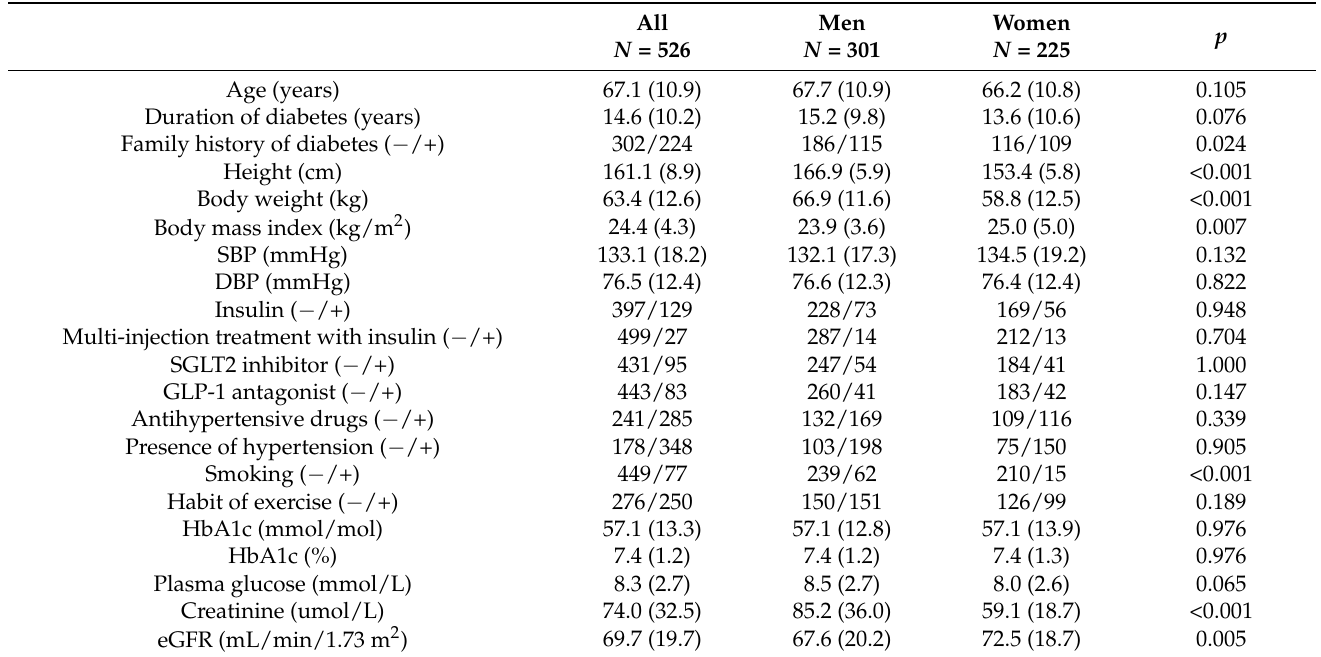
Table 1. Clinical characteristics of study participants.